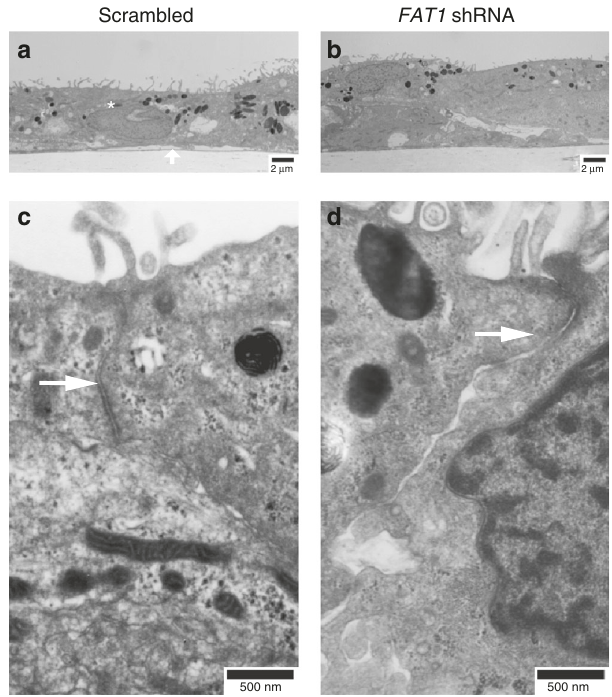
Fig. 4 FAT1 knockdown results in a failure to organize RPE cells into a monolayer. Transmission electron miscroscopy (TEM) of RPE cells cultured on trans-wells for 2 weeks following treatment with scrambled ( a , c ) and FAT1 shRNA ( b , d ). A transverse section depicting RPE cells (*, scale bar is 2 µ m) sitting on top of trans-well membrane ( a , arrow). A higher magni fi cation showing epithelial tight junction ( c , d , arrow, scale bar is 500 nm) between two neighboring